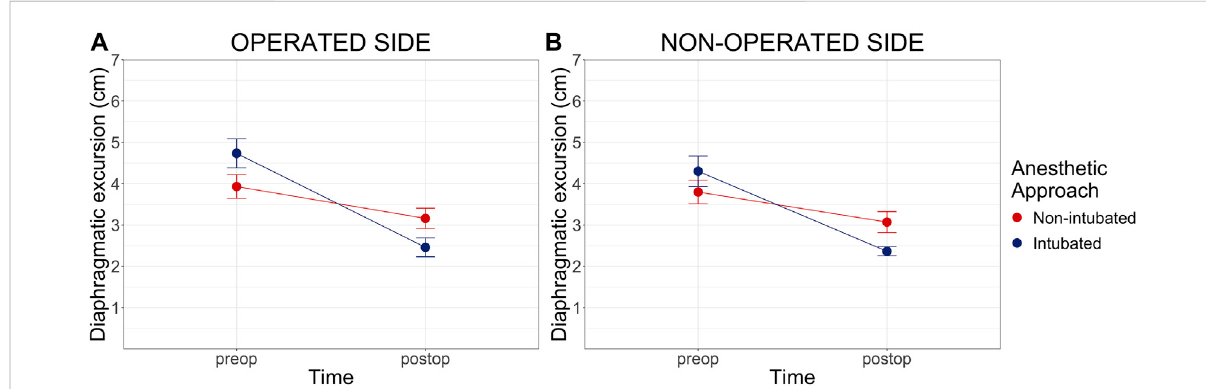
FIGURE 3 Preoperative and Postoperative maximal diaphragmatic excursion. Preop = preoperative, postop = postoperative. Cm of diaphragmatic excursion pre and post-operatively on both the operated (Panel A) and non-operated side (Panel B). Diaphragmatic excursion data are shown as mean and standard error (error bars). Two-way analysis of variance (ANOVA) comparison for repeated measure between groups: p = 0.001 on the operated side and p = 0.005 on the non-operated